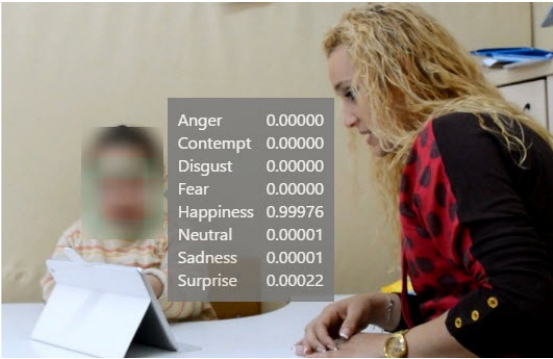
Figure 5. Student 3’s emotional analysis